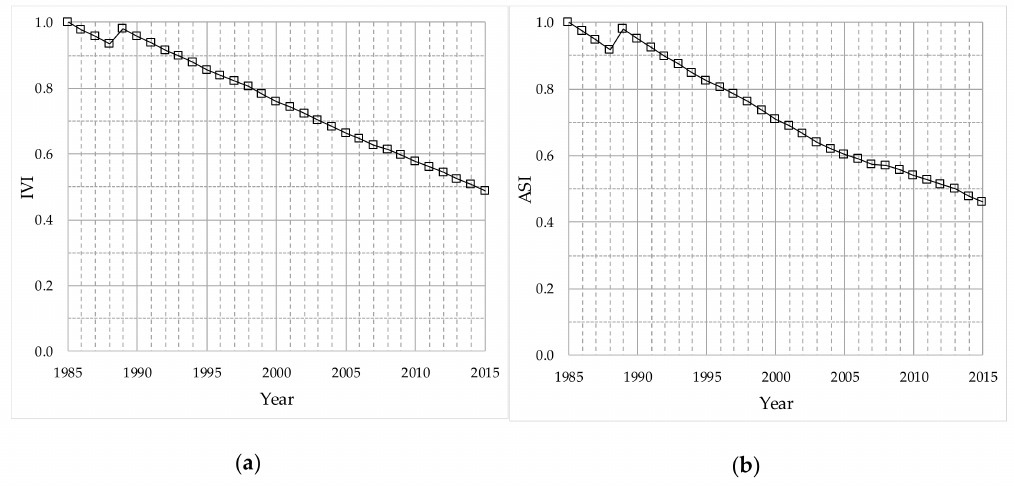
Figure 6. Condition assessment for Operational Sub-system 1: ( a ) IVI index; ( b ) ASI index.